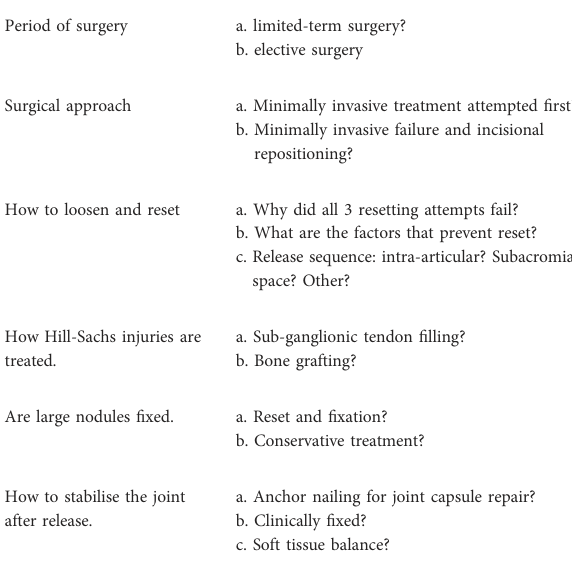
TABLE 1 Pre-operative discussion